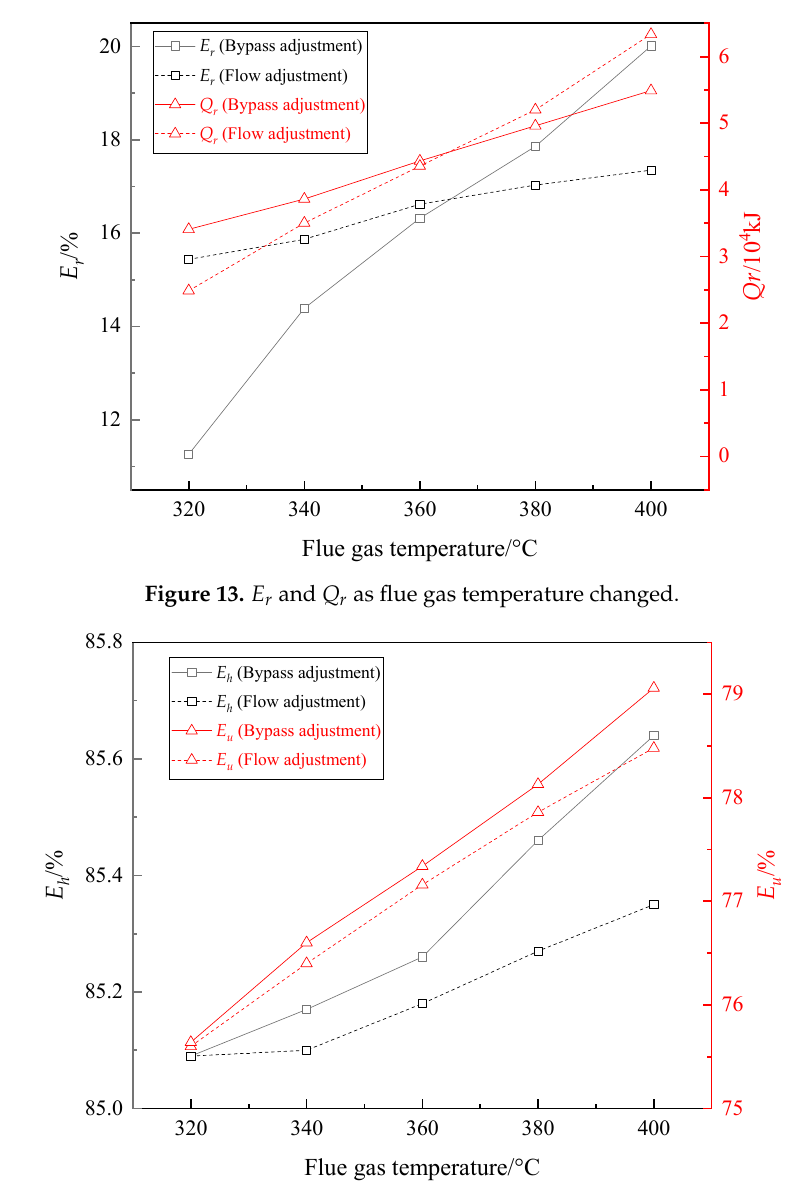
Figure 15. EGT as flue gas temperature changed. Similar to the increasing of flue gas flow, the EGT may also appear to be too lower or higher than the target temperature as the flue gas temperature changes, and the adjustment strategy is also to increase the bypass flue gas flow percentage and the water flow percentage of AE at the same time when the EGT is too higher than target valve, and reduce the flows’ percentage when the EGT is too lower than the target value. 6.3. Adjustment as Ambient Air Temperature Changed In order to obtain the adjustment strategy when the ambient air temperature changes, experiments were carried out in a period with relatively stable air temperature in different seasons. The flue gas temperature was kept at 380 °C, and the total flue gas flow was kept at maximum value. As the air temperature changed, the bypass plug valve was regulated to ensure the EGT at around 85 °C with the opening of other valves unchanged. When the ambient air temperature rose from –5.1 °C to 28.4 °C, the percentage of the bypass flue gas flow increased from 12.7% to 16.0%, as shown in Figure 16.